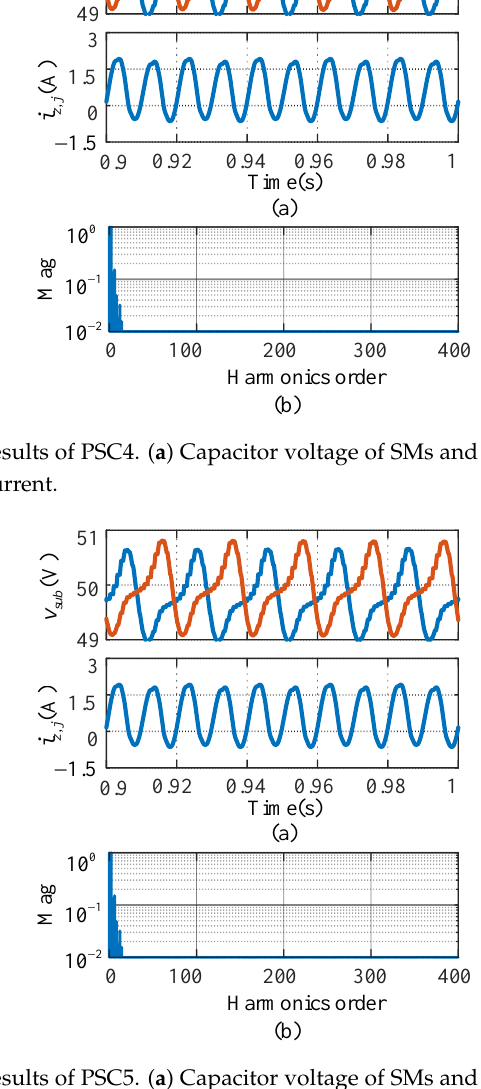
Figure 18. Simulation results of PSC5. ( a ) Capacitor voltage of SMs and circulating current. ( b ) FFT analysis of circulating